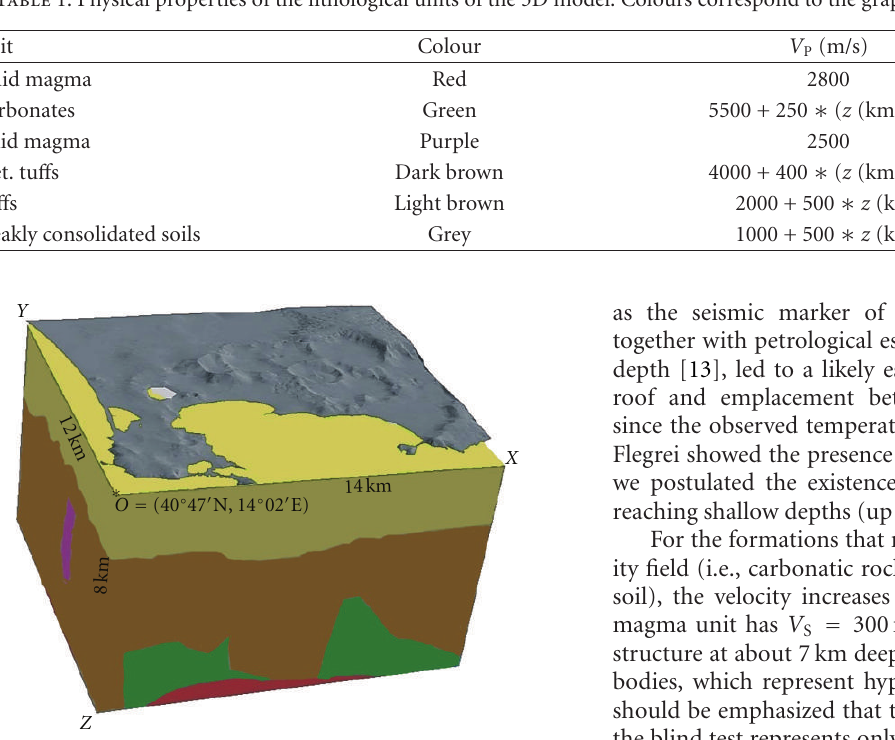
Table 1: Physical properties of the lithological units of the 3D model. Colours correspond to the graphical representation of Figure 3.